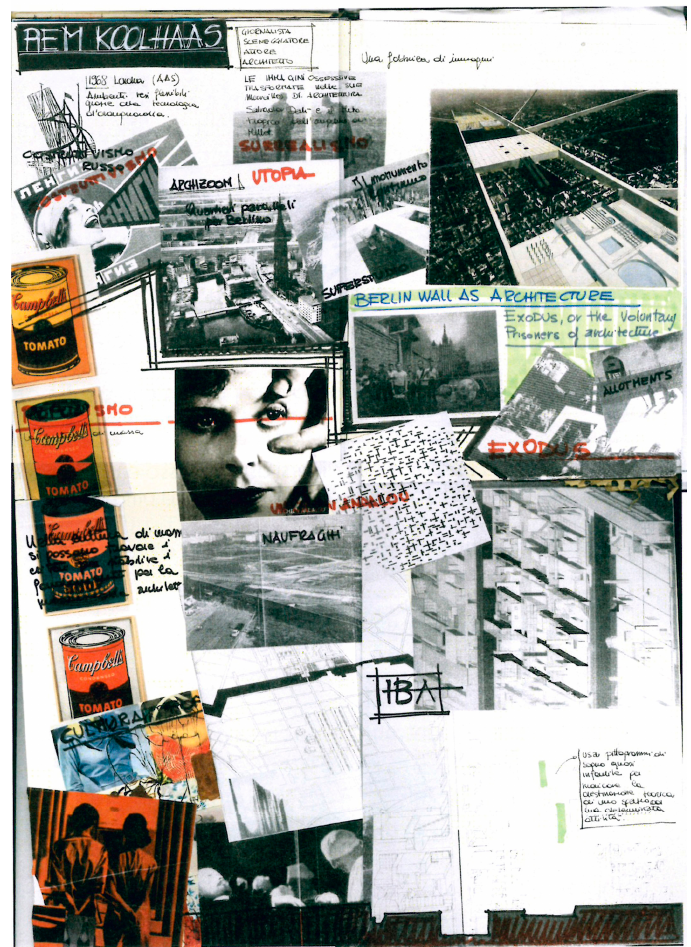
Figure 7. Giulia Bertola, Analytic interpretative collage of Koolhaas’s competition entry for IBA 84.